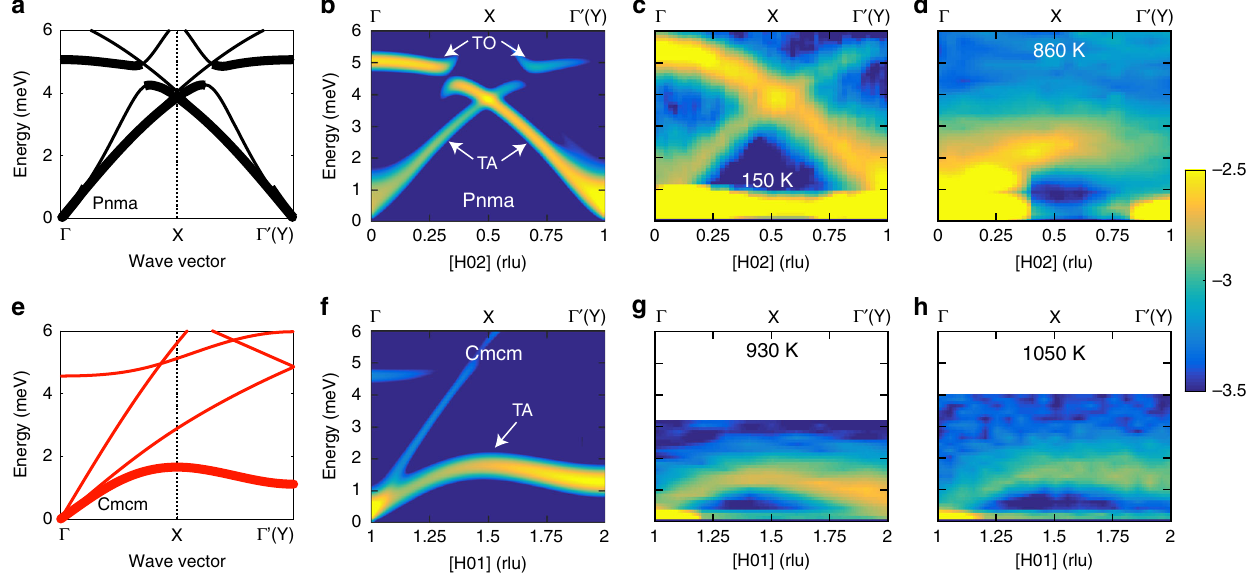
Fig. 2 Extended anharmonic collapse of phonon dispersions. Evolution of SnS phonon dispersions and dynamical susceptibility ( χ ″ ( Q , E )) across the structural phase transition. Upper panels are for the Pnma phase whereas lower panels show the Cmcm phase. Low energy dispersions computed in the Pnma phase with the harmonic approximation ( a ) and the Cmcm phase with TDEP at 800 K ( e ), for wave-vectors along [100] (Pnma notation). Thicker lines indicate which dispersions are seen in the experimental data. The same reciprocal path is plotted in both panels, corresponding to Γ – Y in the Cmcm phase and Γ – X – Γ 0 in the Pnma phase, where Γ 0 is a superlattice zone center (Fig. 1). High symmetry points of the Pnma Brillioun zone (BZ) are shown without parentheses whereas those for the Cmcm BZ are shown in parentheses. b , f Show the corresponding computed χ ″ ( Q , E ) along [ H 02] and [ H 01] where Pnma notation for the Miller indices are used throughout. c , d , g , h Highlight the temperature evolution of χ ″ ( Q , E ) measured with INS along the same direction in the irreducible BZ as ( b , f ). As indicated in ( b , f ), these reciprocal-space paths highlight low-energy TA c and TO c phonons polarized along c in the Pnma phase ( c , d ) and Cmcm phase ( g , h ). The paths shown in ( b – d ) are not exactly equivalent to those shown in ( f – h ) but show the same direction in the irreducible BZ and have very similar polarization conditions such that all show c -polarized modes. Data were collected on CNCS ( c ), HB-3 ( d ) and CTAX ( g , h ). Intensity is plotted in a log 10 scale on color